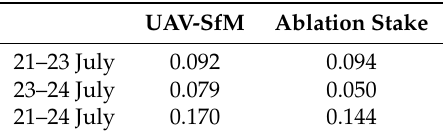
Table 4. Total specific melt in m w.e. calculated for the study area using the UAV-SfM measurements and ablation stake measurements. Ice density was assumed to be 917 kg m − 3